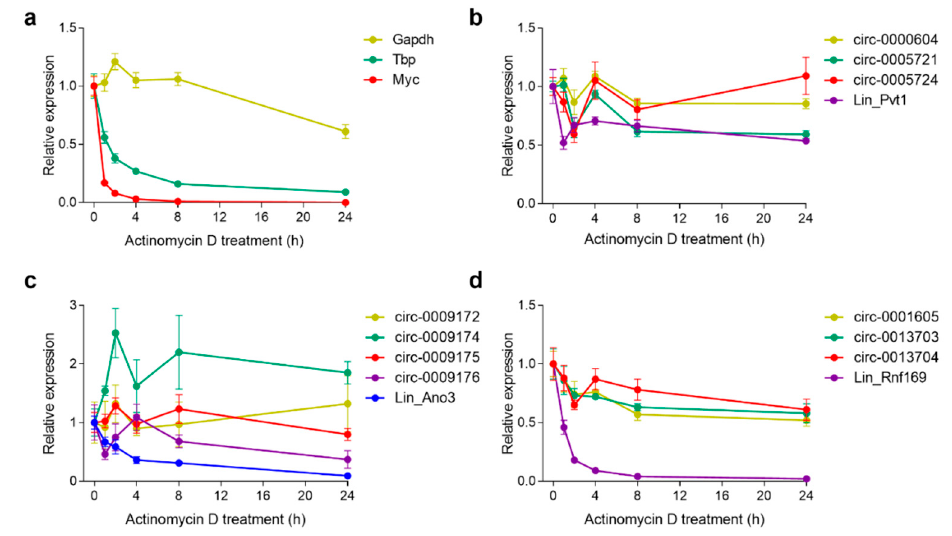
Figure 3. RNA stability at different times points after Actinomycin-D treatment. Relative expression levels of ( a ) control genes ( Tbp , Myc and Gapdh ); ( b ) Pvt1 ; ( c ) Ano3 ; and, ( d ) Rnf169 transcript variants in primary cortical neurons at 0, 1, 2, 4, 8, and 24 h of treatment with Actinomycin-D. Data shown are means ± s.e.m. of 4 biological replicates ( n = 4).